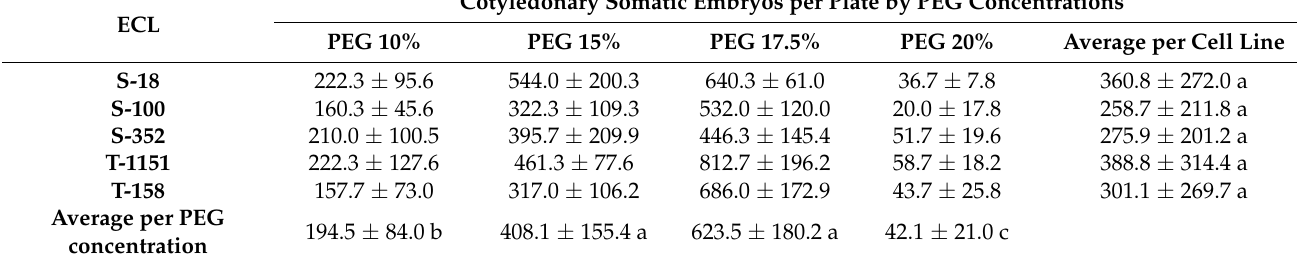
Table 3. Effect of polyethylene glycol (PEG) concentration on somatic embryo maturation efficiency of sugi embryogenic cell lines (ECLs). Data are presented as the mean ± SD (standard deviation) of the number of cotyledonary somatic embryos per plate from three replicates for each ECL matured on media containing different concentrations of PEG.